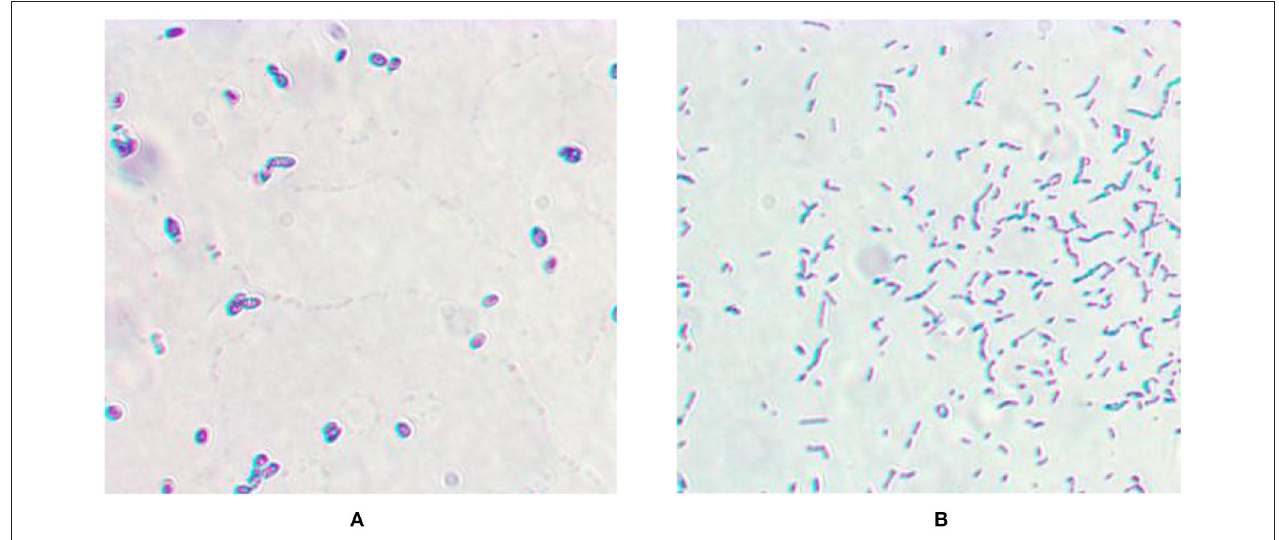
FIGURE 1 | Microscopic morphology. (A) Gram staining of Candida utilis CU-2; (B) Gram staining of Lactobacillus casei